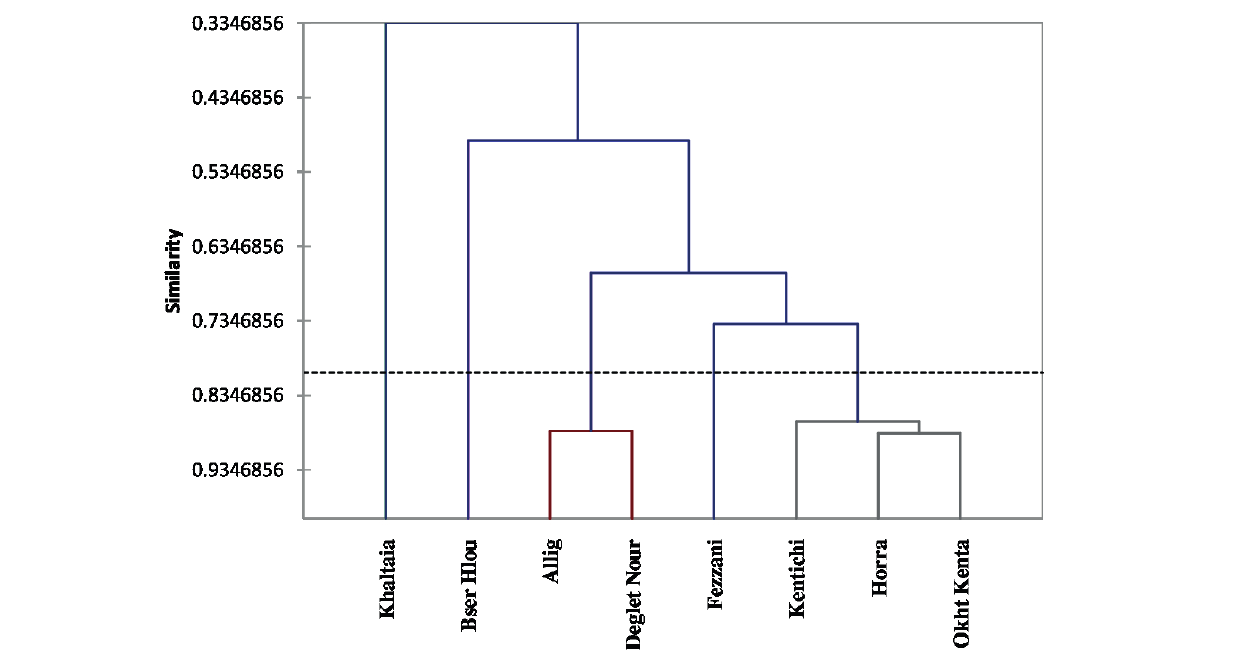
FIGURE 2 - Dendrogram showing hierarchical clustering of date palm varieties based on aromatic volatiles